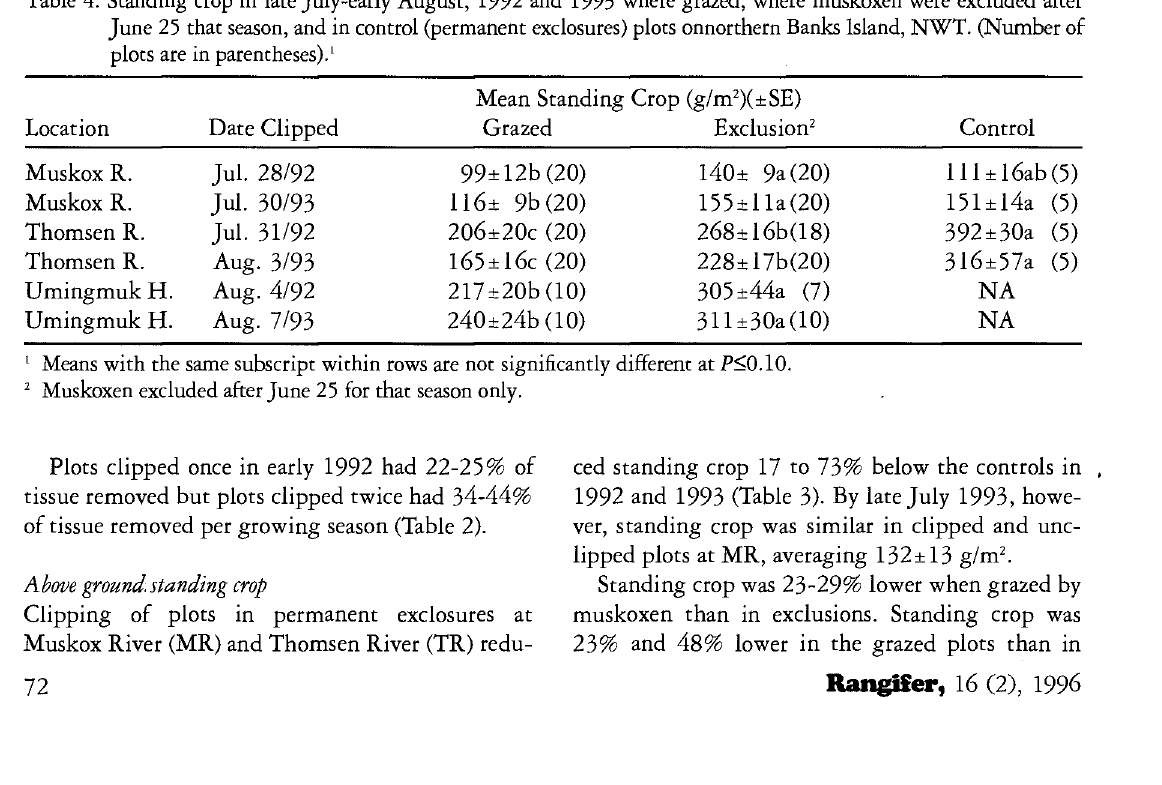
Table 4. Standing crop in late July-early August, 1992 and 1993 where grazed, where muskoxen were excluded after June 25 that season, and in control (permanent exclosures) plots onnorthern Banks Island, NWT. (Number of plots are in parentheses).